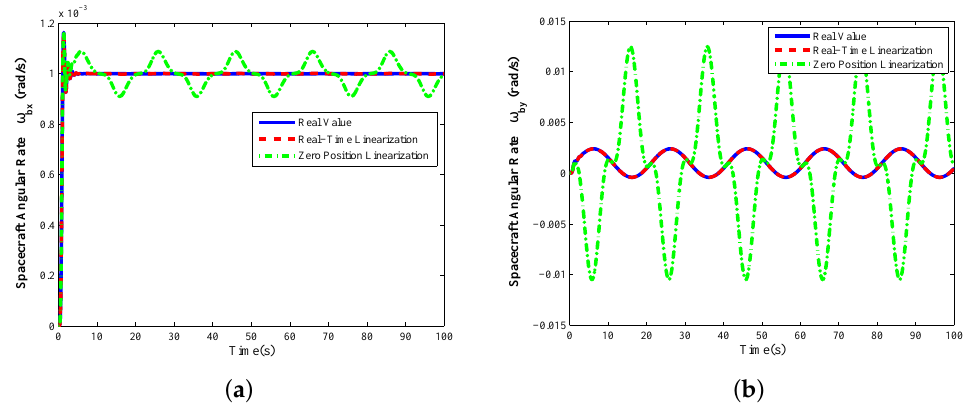
Figure 8. Dynamic measurement φ xd = 4sin ( 2 π · 0.05 t ) ◦ , φ yd = 0 ◦ , constant motor spin rate ˙ θ zd = 157.04 + 20sin ( 2 π · 0.02 t ) rad/s: ( a ) X -axis angular rate sensing of spacecraft ω bx ; ( b ) Y -axis angular rate sensing of spacecraft ω by